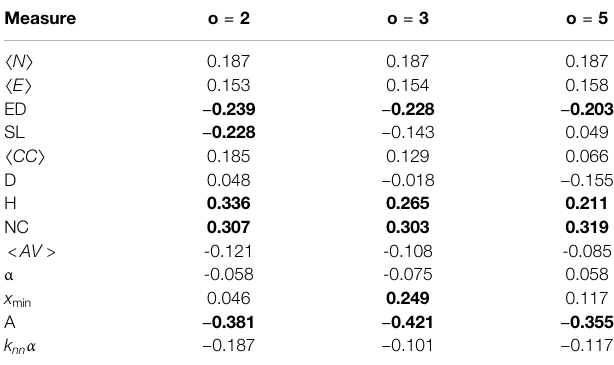
TABLE 2 | Spearman Correlation between network measures and MMSE score. Signi fi cant correlations are marked with bold font. Measure